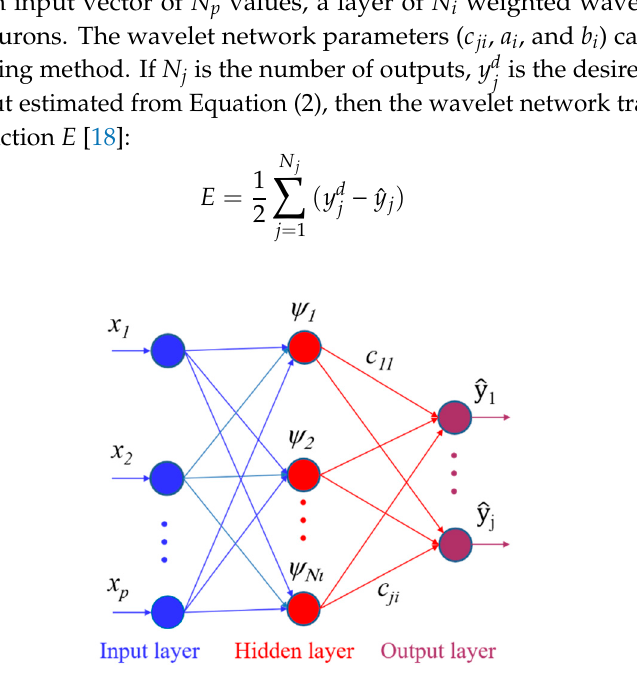
Figure 1. General wavelet network (WN) model structure ( N p -input, N i -wavelons, and N j -outputs).